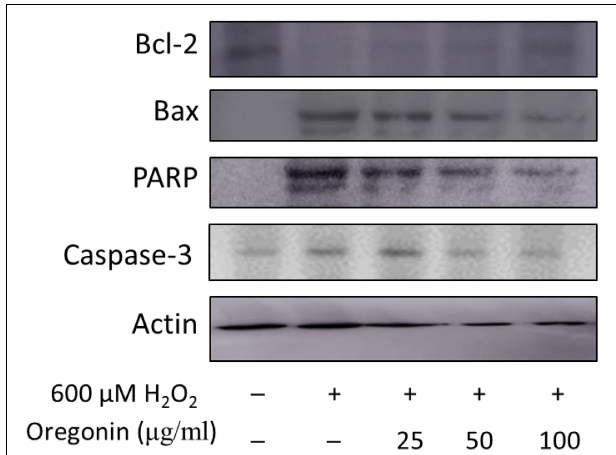
FIGURE 5 | Anti-apoptotic effects of oregonin on H 2 O 2 -induced oxidative damages in hair follicle dermal papilla cells. The cells (1 × 10 5 cells) were pre-incubated with oregonin in various dosages or in control medium for 10 min at 37 ◦ C in a CO 2 incubator. Then, the cells were treated with H 2 O 2 (final concentration, 600 µ M) and further incubated for 12 h. The harvested cells were solubilized with protease inhibitors (Sigma-Aldrich, MO, United States) containing radioimmunoprecipitation assay buffer (Elpis Biotech, Seoul, South Korea) and analyzed by western blotting by using PARP-1, Bax, Bcl-2, caspase-3, and β -actin-specific antibody. Data were expressed as representative results from three independent experiments. +, present; –, absent.